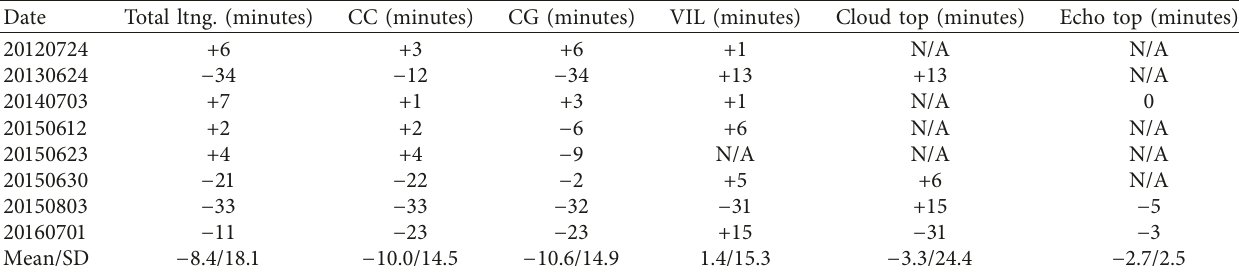
Table 4: Time of 2 σ maxima of each parameter with respect to the severe wind report.